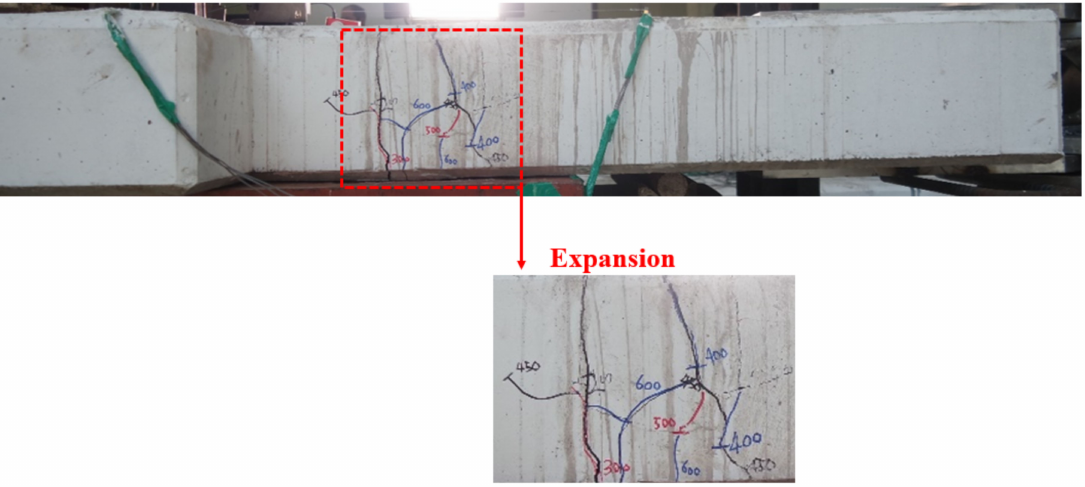
Figure 11. Final crack geometry in J100-HB-SP (800 kN). The numbers in the expansion represent the crack tip locations at that load (in